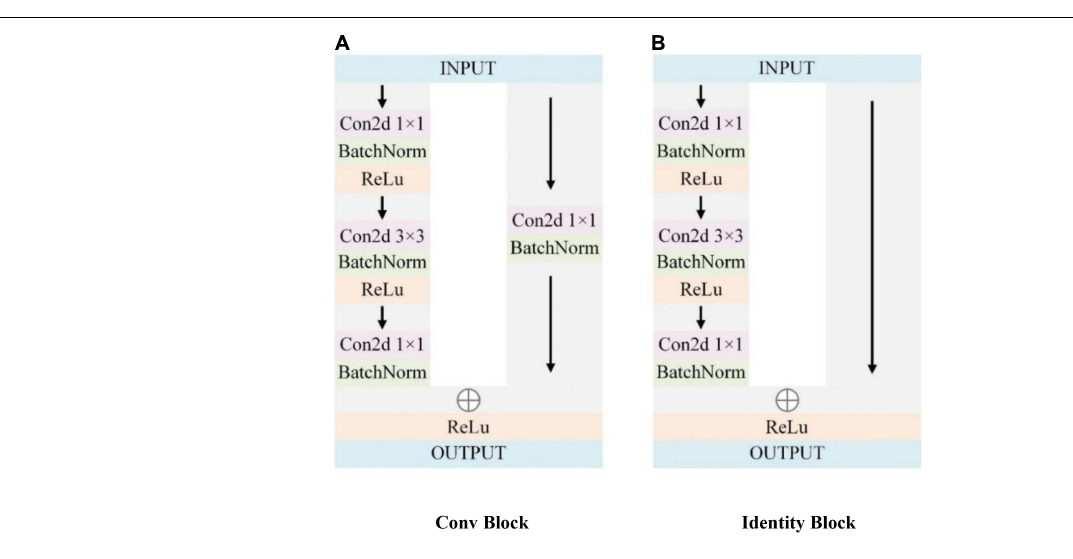
FIGURE 4 | MRI image processed by augmentation methods.